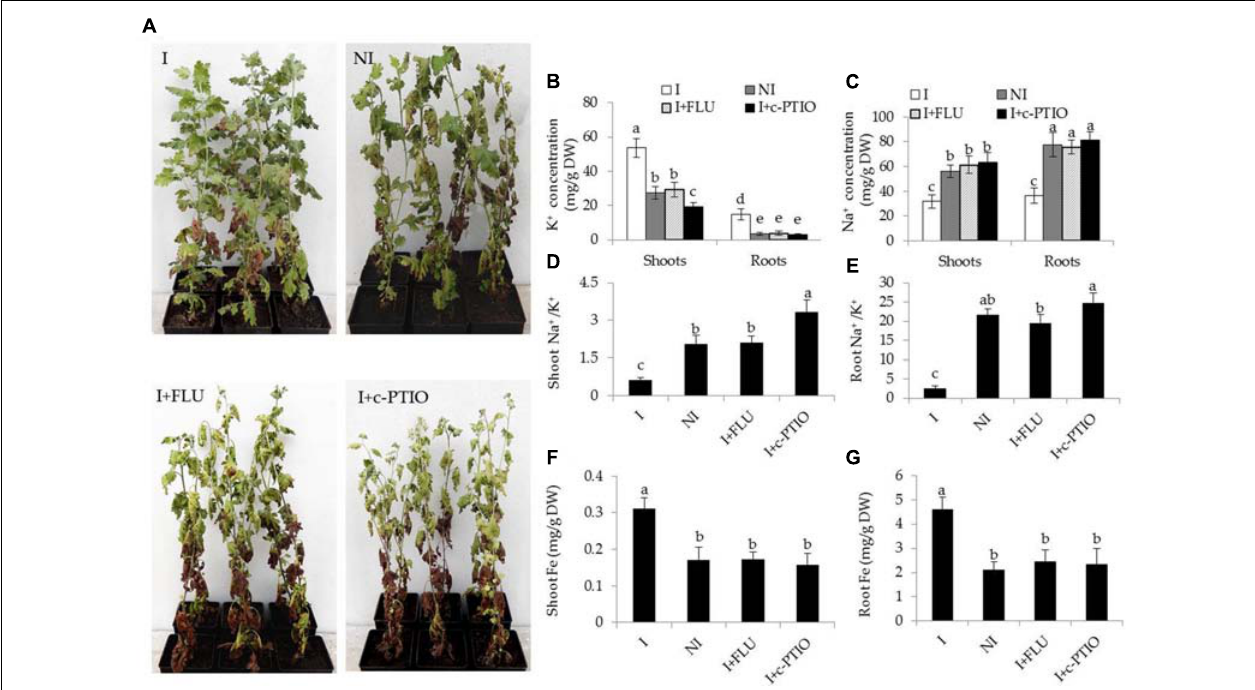
FIGURE 8 | Treatment with FLU or c-PTIO abrogated the effects of B. licheniformis SA03 on saline–alkaline tolerance of Chrysanthemum plants. After 10 days of bacterial inoculation, plants were subjected to saline–alkaline stress for 4 weeks with or without FLU or c-PTIO treatments. These plants were used to analyze (A) growth phenotypes, shoot and root (B) K + or (C) Na + concentration, shoot (D) and root (E) Na + /K + ratio, shoot (F) and root (G) Fe concentrations. I, inoculated plants; NI, non-inoculated plants; BS, before the stress treatment; AS, after the stress treatment. Data are expressed as the mean values of three replicates ( ± SE) with 10 plants each. Different letters indicate significant differences using one-way ANOVA followed by the Duncan’s multiple range test at P < 0.05.